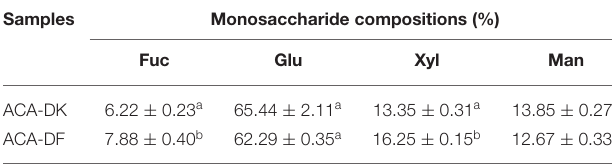
TABLE 2 | Monosaccharide compositions of ACA-DK and ACA-DF.